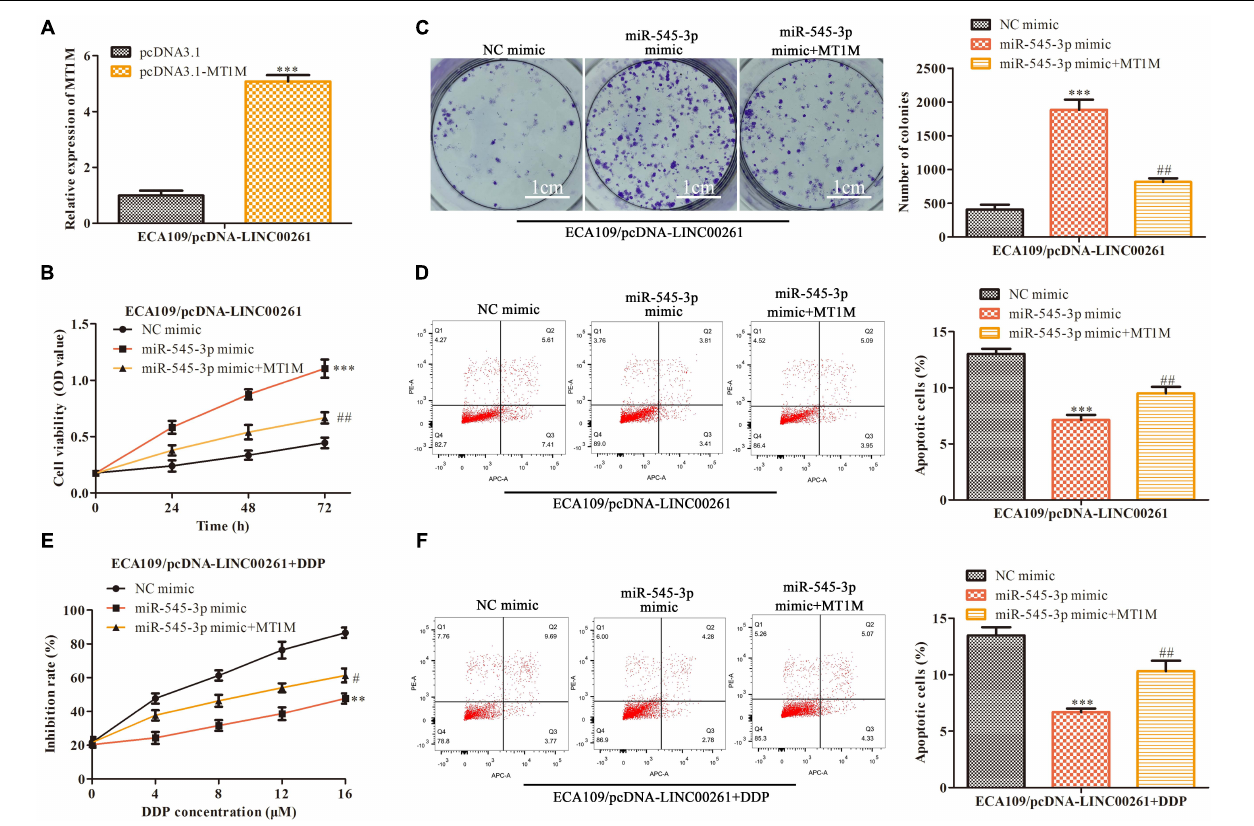
FIGURE 7 | LINC00261 inhibits ESCC progression and DDP resistance by miR-545-3p/MT1M axis. MT1M, miR-545-3p and their corresponding control were used to transfect the stable overexpression LINC00261 cell line (ECA109/pcDNA-LINC00261). (A) The expression of MT1M detected by RT-qPCR. ** P < 0.01, *** P < 0.001 compared with the corresponding control group. (B) The proliferation assessed by CCK-8 assay. (C) The proliferation measured by clone formation assay. (D) The apoptotic cells detected by flow cytometry assay. (E) The proliferation inhibition rate assessed by CCK-8 assay. (F) The apoptotic cell detected by flow cytometry assay. ** P < 0.01, *** P < 0.001 compared with the NC-mimic group, # P < 0.05, ## P < 0.01 compared with the miR-535-3p-mimic